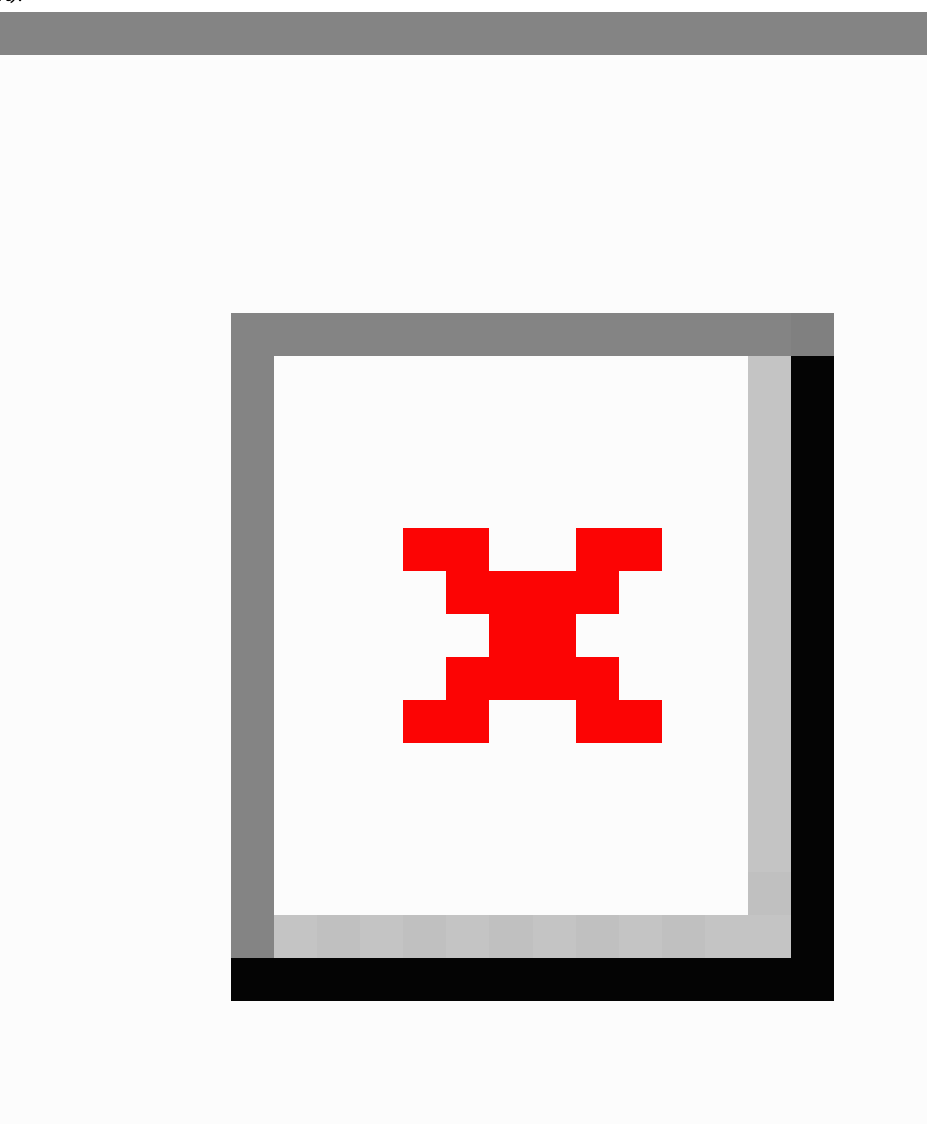
Figure 1. Screenshots of Oiva app: main view (top left), exercise browser (top right), instructions for an exercise (bottom left), and reflection screen (bottom